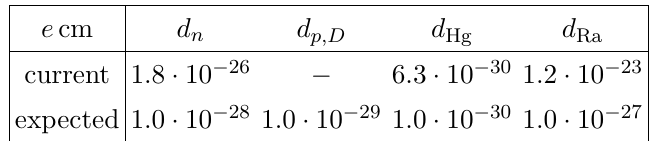
Table 3 . The first row shows the current 90% C.L limits on the EDMs of the neutron [62, 140, 141], 199 Hg [142, 143], and 225 Ra [144]. The second row shows the expected sensitivities of future EDM experiments, see ref.